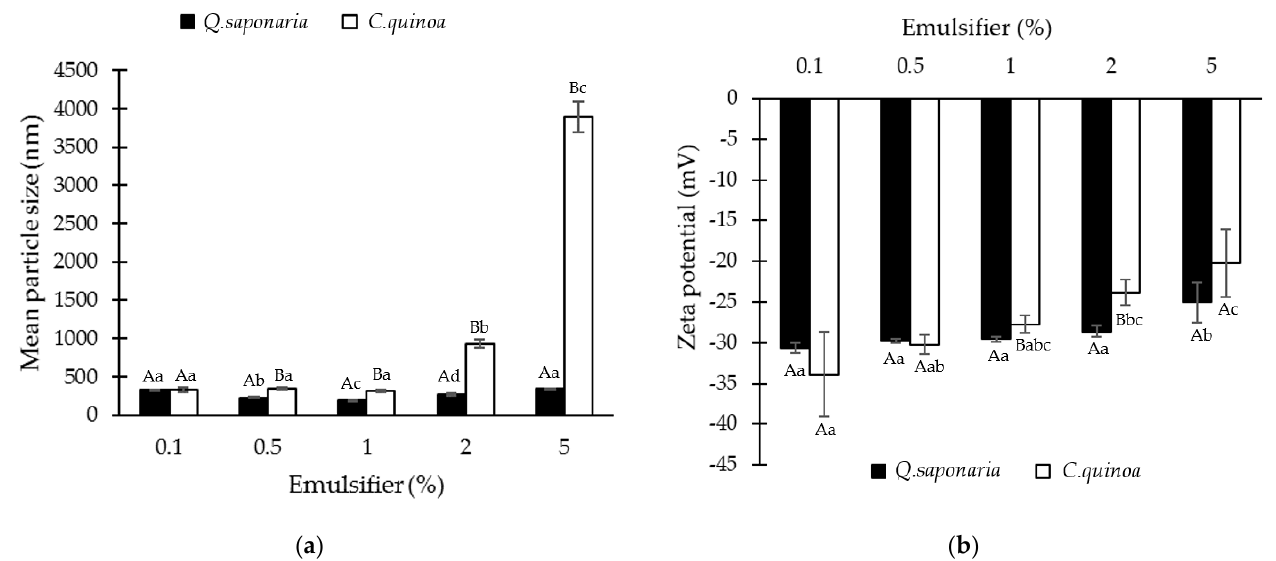
Figure 1. Influence of emulsifier concentration on emulsion ( a ) mean particle size and ( b ) zeta potential. Different capital letters indicate significant differences ( p ≤ 0.05) of the mean particle size or zeta potential among the different emulsion types ( C. quinoa, Q. saponaria ) within the same emulsifier concentration. Different lowercase letters indicate significant differences ( p ≤ 0.05) of the mean particle size or zeta potential among the different emulsifier concentrations (0.1, 0.5, 1, 2, 5%) within the same emulsion type.